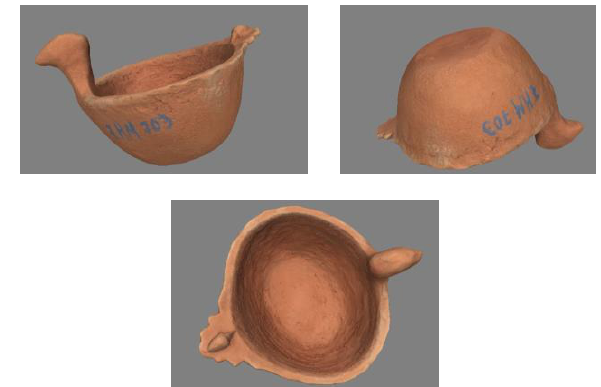
Figure 7: Different views of the FS 3D model of the